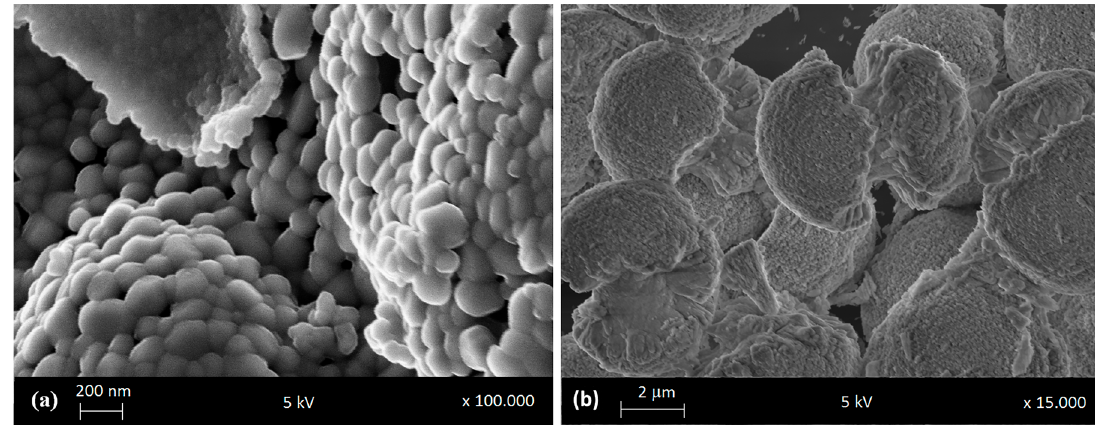
Figure 2. FE-SEM images of (a) CWOP and (b) CWOH powders Table 2. Eg values obtained in this work (*) and values found in the literature. MPP = Polymeric precursor method; MAH = Microwave- assisted hydrothermal; CP = Co precipitation; SR = Sonochemistry reaction. SPR = Solid-phase reaction. Method